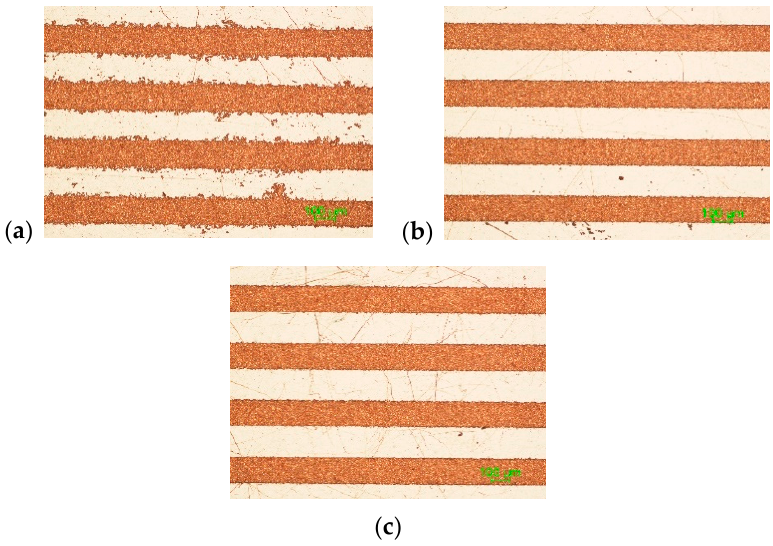
Figure 10. Plated lines after applying non-overlapped scanning in the first scanning run technique: ( a ) X1 / 2D; ( b ) X1D; ( c ) X3 / 2D. The scanning speed was 4.8 m / s, the pulse repetition rate was 400 kHz and the average laser power was 5 W. The scale bar of all three images corresponds to 100 µm.